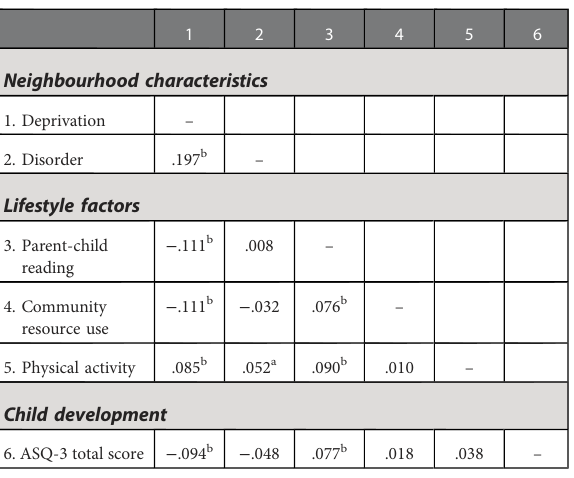
TABLE 2 Pearson ’ s correlation coef fi